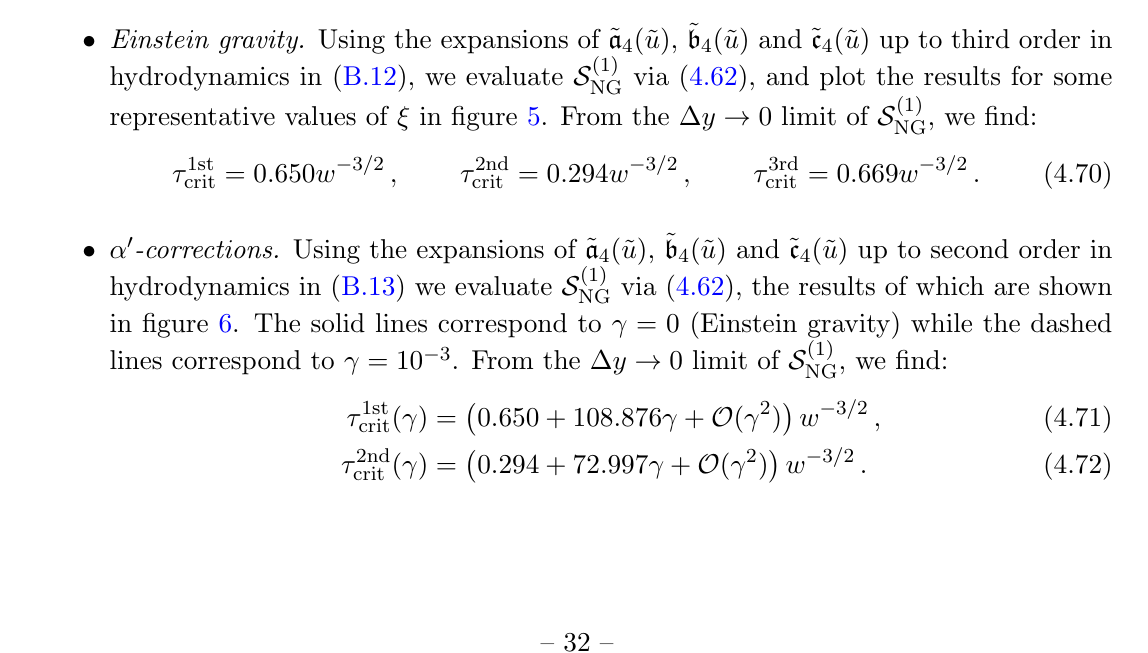
Figure 5 . Left: plots for ~ S (1) f 0 ; 0 : 15 ; 0 : 3 ; 0 : 45 ; 0 : 6 g depicted in blue, orange, green, red and purple, respectively. The solid lines correspond to 3 rd order hydrodynamics; the dashed and dotted lines correspond to 2 nd and 1 st order hydrodynamics, respectively. Right: plots for ~ S (1) depicted in green, orange and blue, respectively. The dashed vertical lines correspond to the critical times at each order in